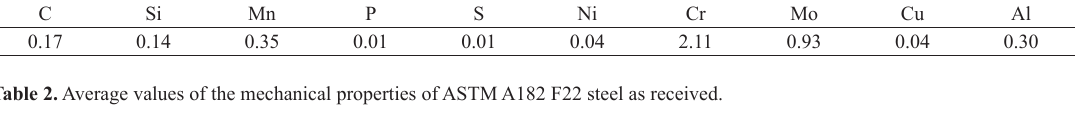
Table 2. Average values of the mechanical properties of ASTM A182 F22 steel as received. Hardness (HRC)